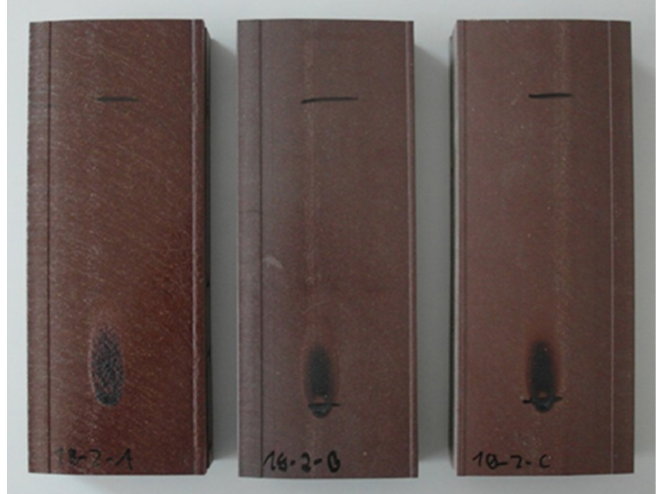
Figure 4. Solid profiles after the single flame source test (EN ISO 11925-2). From left to right: reference without FR, profiles with Budit 669, and profiles with FR CROS 490. Horizontal line on profiles indicates 150 mm-mark (vertical flame spread within 60 s after start of the flame treatment shall not be more than 150 mm).